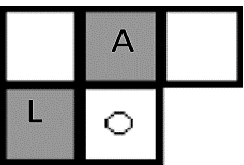
Figure 1. Position of the two predictive macroblocks, where A represents the location of motion vector A (MV A ), while L represents the location of motion vector L (MV L ). Algorithm 1 Neighboring Macroblocks.